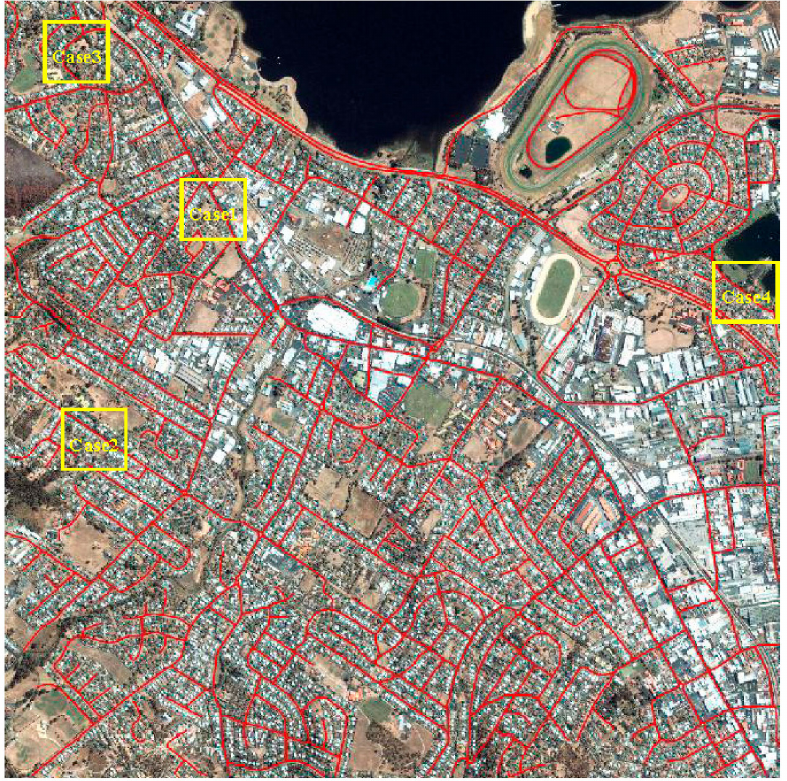
Figure 5. Road extraction result provided by the proposed ECFM method for an IKONOS